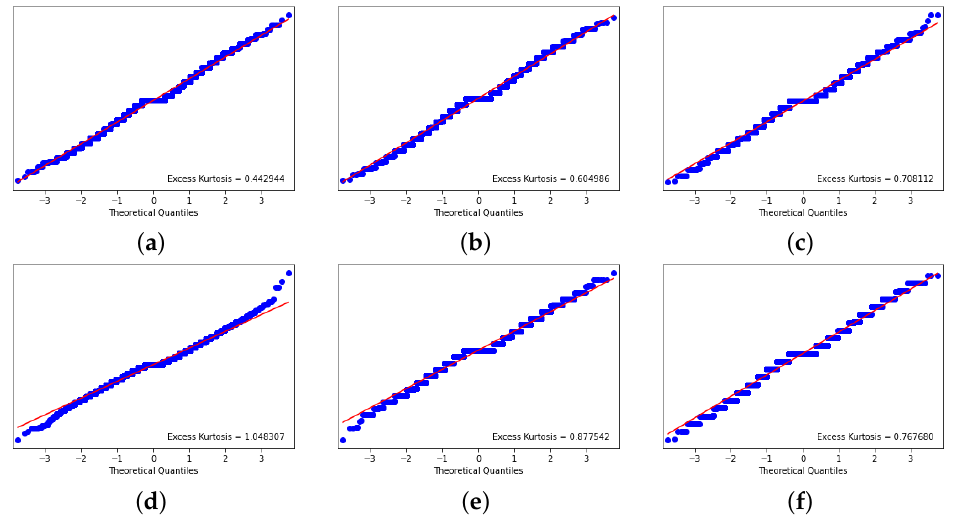
Figure 6. 2-second Normal Q–Q plots. ( a ) CDA. ( b ) FBA (0.5). ( c ) FBA (1.0). ( d ) FBA (1.5). ( e ) HVCDA. ( f ) FBA